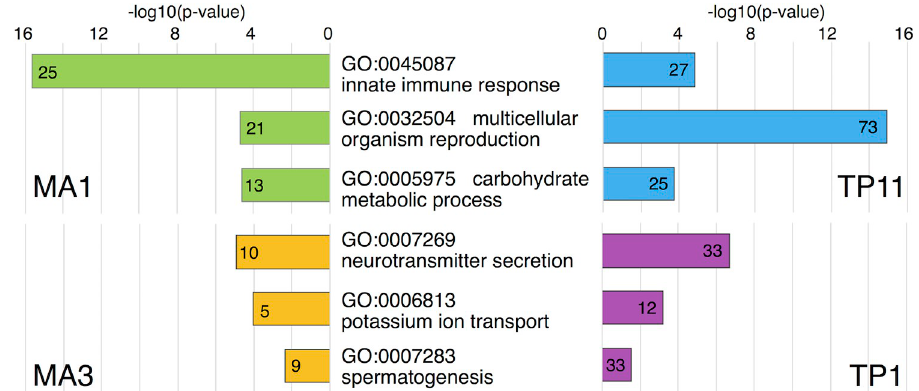
Fig 5. GO analysis for the clustering groups. GO analysis (GOTERM_BP_DIRECT category) for each clustering group was performed (S4 and S5 Tables). MA1 (green bars) and TP11 (blue bars) groups shared some enriched GO terms. Among them, three representative GO terms are shown here. Bar graphs show p-values of each GO term, as -log10 values. Numbers under the top of bars indicate numbers of genes matched to the GO terms. MA3 (yellow bars) and TP11 (magenta bars) groups also shared some enriched GO